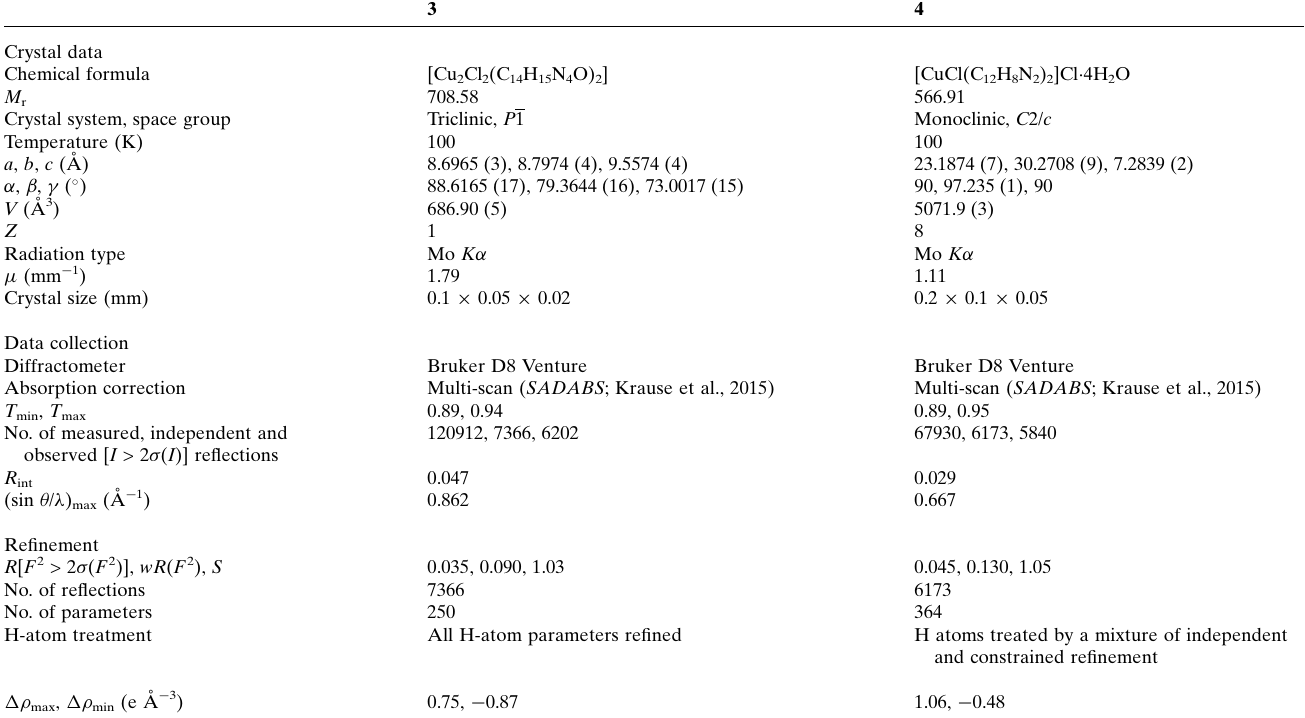
Table 3 Experimental details.